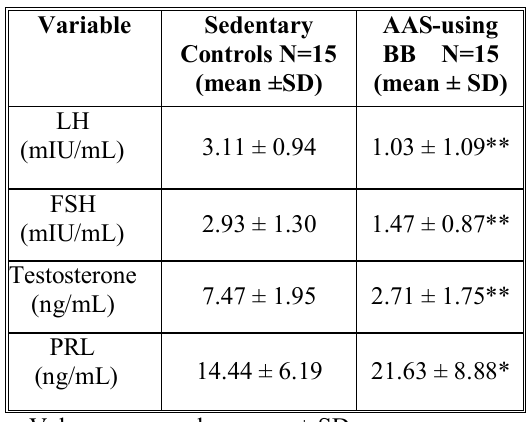
Table 2: Effects of anabolic androgenic steroids on serum hormones in AAS-using bodybuilders compared to sedentary controls.